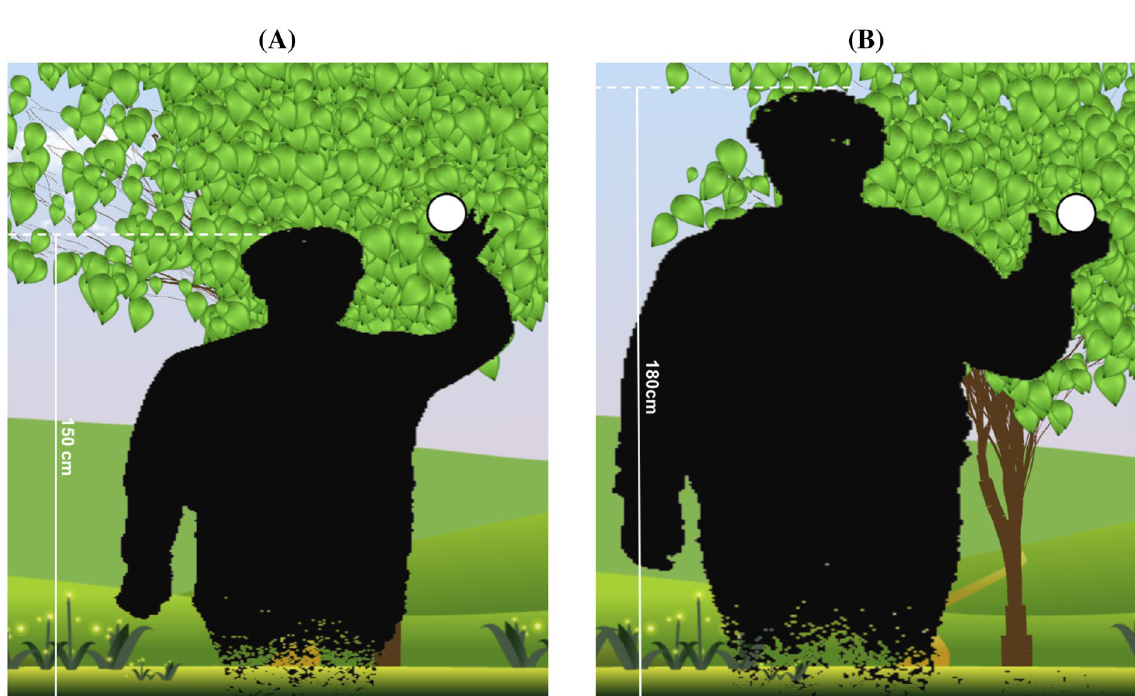
Figure 5. Two different body size conditions in the virtual reality perception tests. ( A ) An original virtual body size condition. ( B ) An enlarged virtual body size